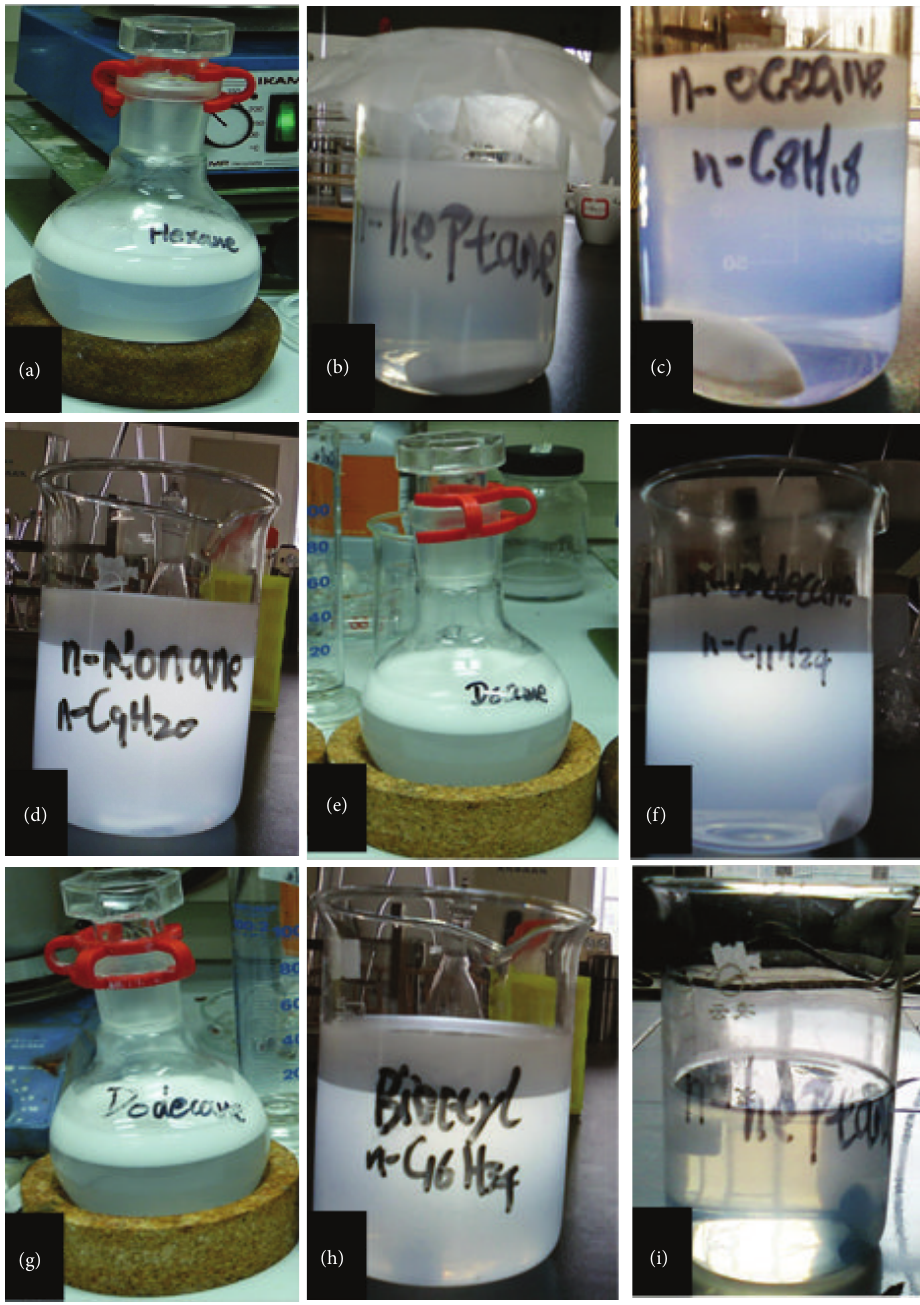
Figure 7: Phase separation of alkane-P123-H 2 O mixture to form upper alkane-rich layer and water-rich layer: (a) 𝑛 -hexane; (b) 𝑛 -heptane; (c) 𝑛 -octane; (d) 𝑛 -nonane; (e) 𝑛 -decane; (f) 𝑛 -undecane; (g) 𝑛 -dodecane; (h) 𝑛 -bioctyl; (i) the upper alkane-rich layer removed heptane- P123-H 2 O